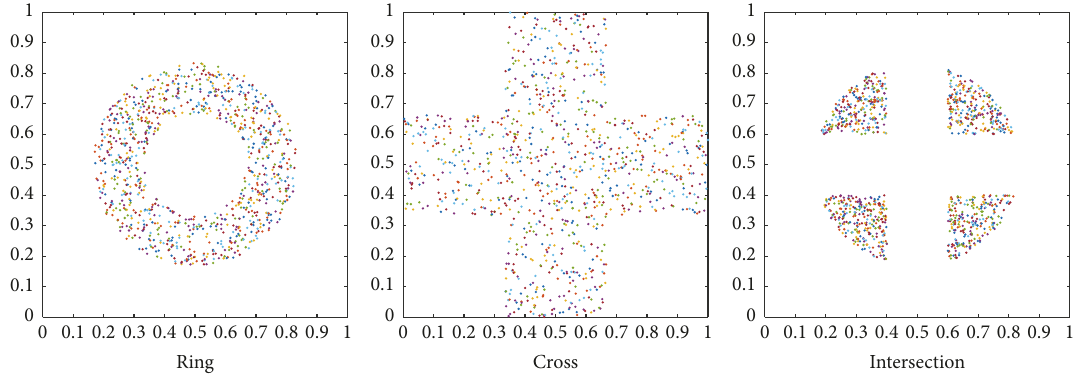
Figure 12: Distributions of Cross, Intersection, and Ring. Table 2: Influence of different self radiuses on CB-RNSA.